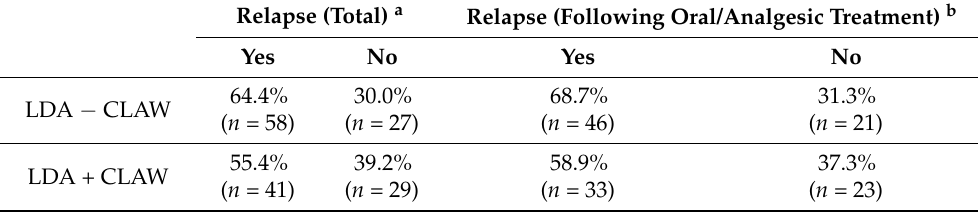
Table 6. Distribution of occurrence of relapse of left displacement of the abomasum (LDA) after rolling in cattle either diagnosed with no (LDA − CLAW) or with (LDA + CLAW) a claw disease, in total, and in animals that received an oral/analgesic treatment. Abomasal rolling was not successful in 5.6% ( n = 5) of animals of LDA − CLAW, and 5.4% ( n = 4) of animals in LDA + CLAW. These animals are not included in the table and percentage presented. There was no significant effect of either presence of claw lesion or oral and/or analgesic treatment on occurrence of relapse in cattle with LDA treated by abomasal rolling. Relapse (Total) a Relapse (Following Oral/Analgesic Treatment) b Yes No Yes No 64.4% 30.0% 68.7% 31.3% LDA − CLAW ( n = 58) ( n = 27) ( n = 46) ( n = 21) 55.4% 39.2% 58.9% 37.3% LDA + CLAW ( n = 41) ( n = 29) ( n = 33) ( n = 23) a Total number is n = 90 for LDA − CLAW, and n = 74 for LDA + CLAW. Data about occurrence of relapse